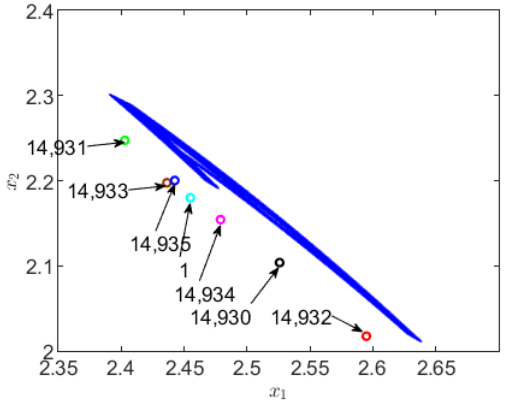
Figure 10. State